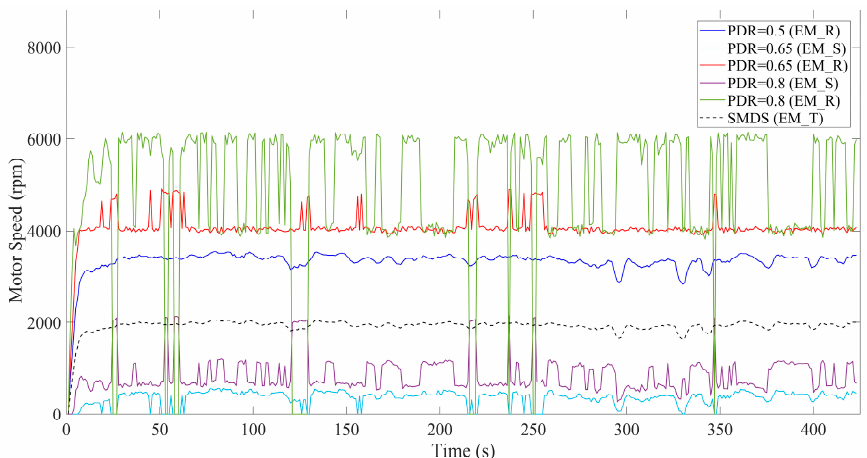
Figure 9. Speed of motors during the plowing cycle.